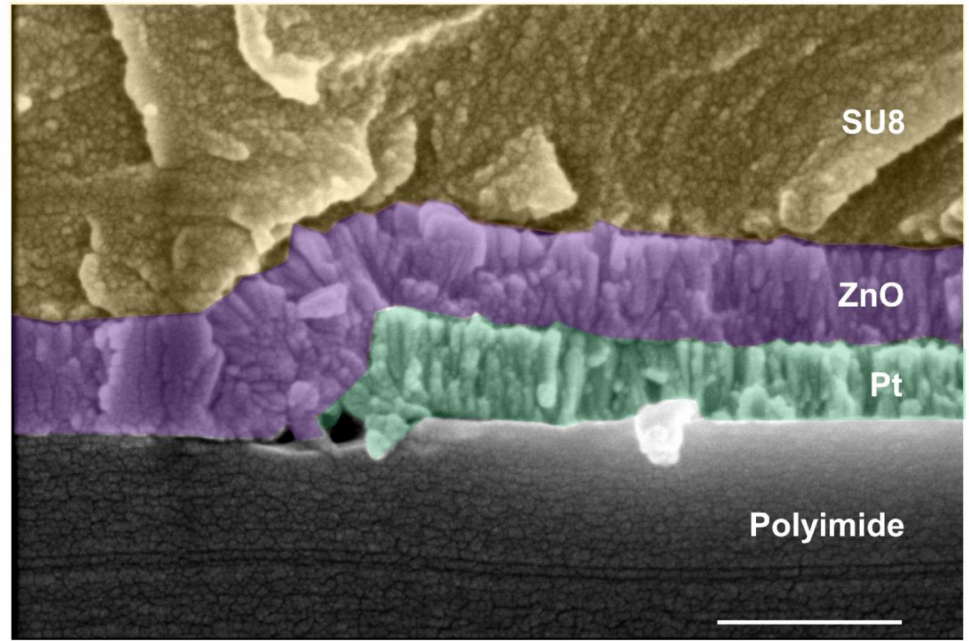
Figure 8. Cross-section showing the conformality of the ZnO thin film deposited by ALD on the polyimide substrate and the platinum metal electrodes. A SU8 resin top layer is deposited to protect the ZnO/Pt junction. The scale bar corresponds to 500